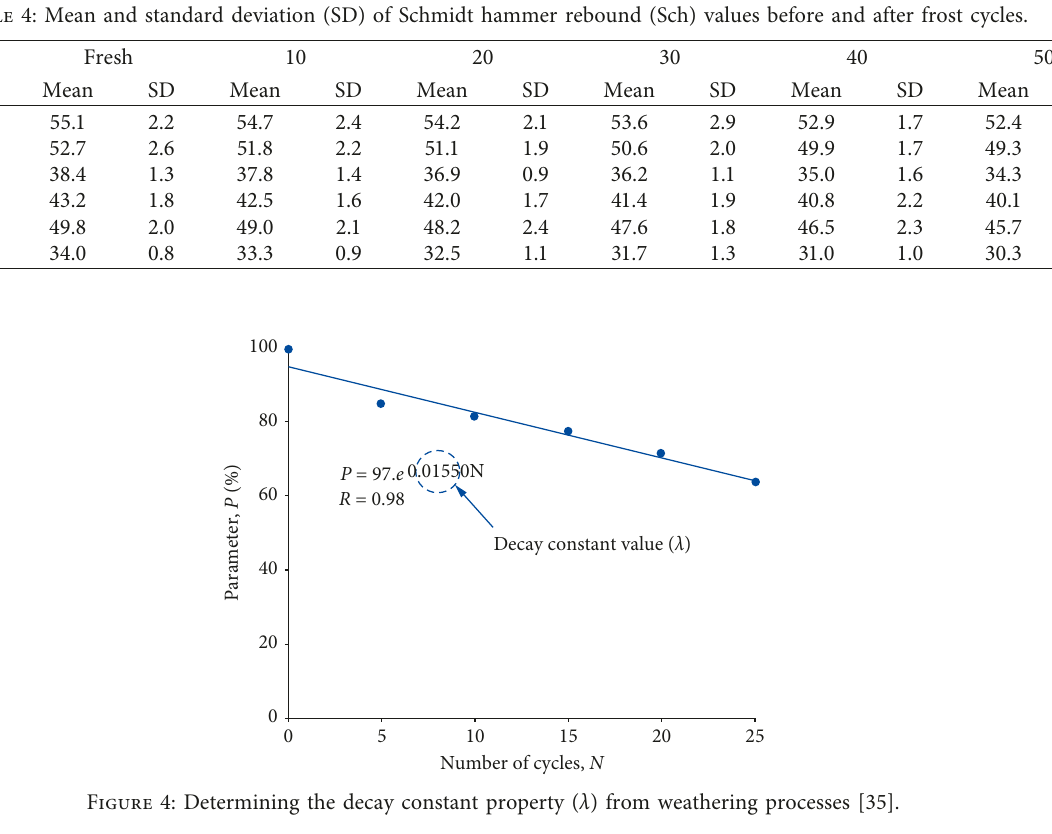
Table 3: Mean and standard deviation (SD) of point load index strength (Is (50)), MPa, values before and after frost cycles. Fresh Cycles